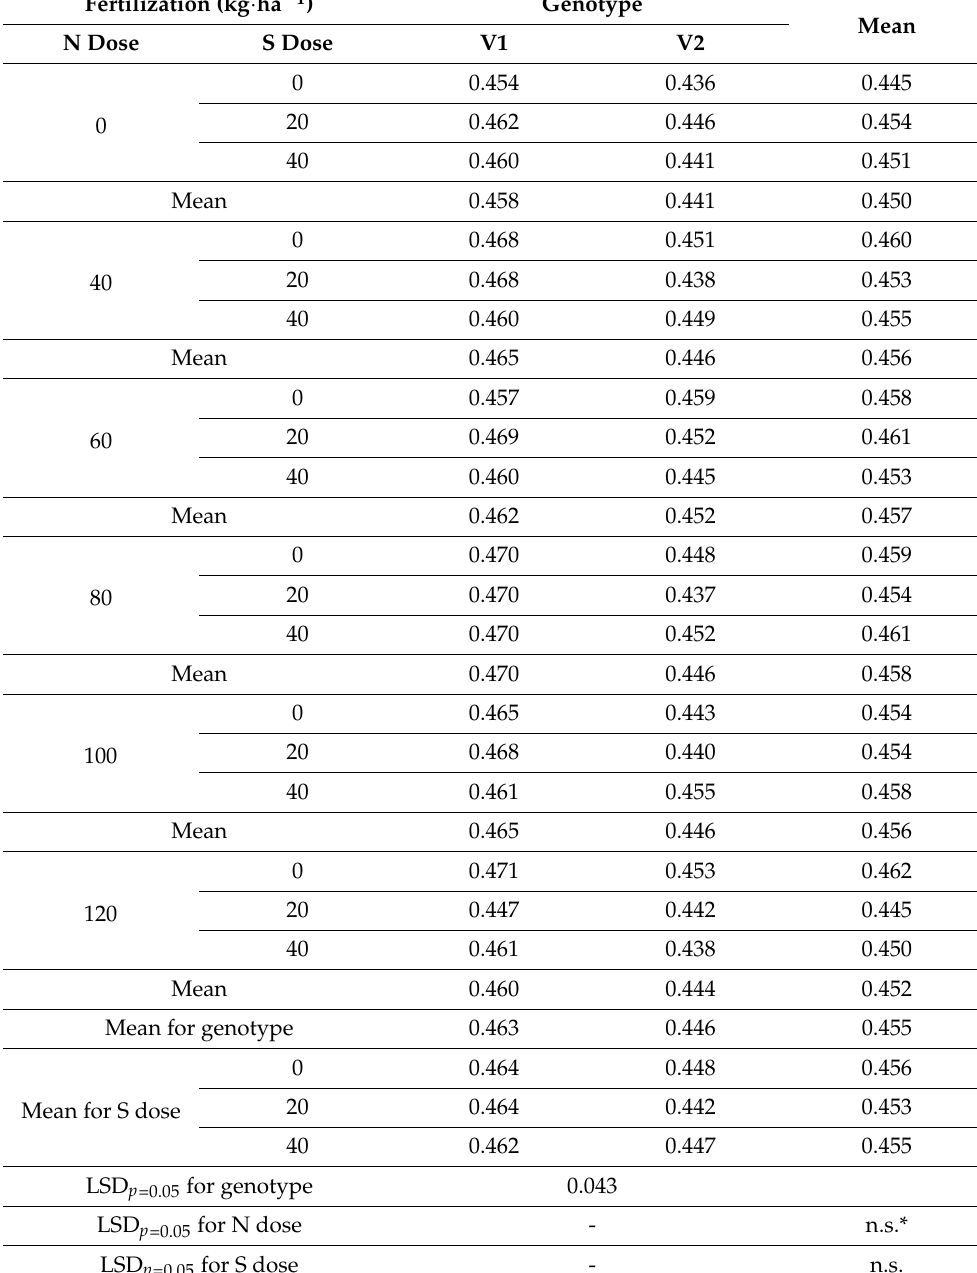
Table 8. EVI index of winter wheat genotypes under